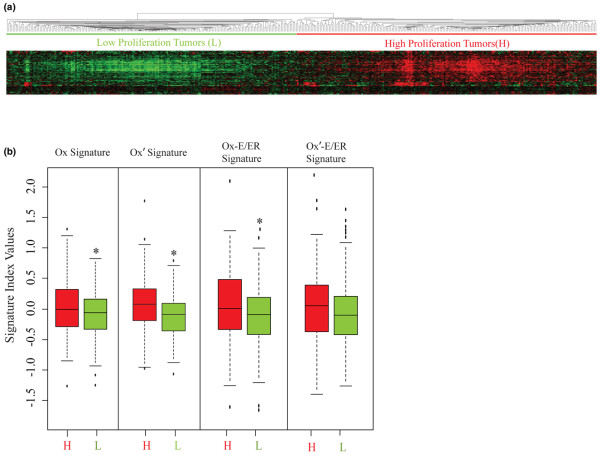
Relationship between oxidative stress and ER-positive tumor proliferation. (a) Unsupervised clustering of 394 estrogen receptor (ER)-positive breast cancers based only on expression of the 71-gene proliferation signature, revealing two major clusters of tumors showing high (H) and low (L) expression of the proliferation genes. (b) Box plots showing the expression indices determined for each of the Ox, Ox', Ox-E/ER, and Ox'-E/ER signatures in tumors identified from (panel a) as having either high (H) or low (L) expression of the proliferation genes. *Statistically significant difference in mean expression index (t-test P < 0.05). Ox-E/ER, oxidant-sensitive estrogen/ER gene signature.